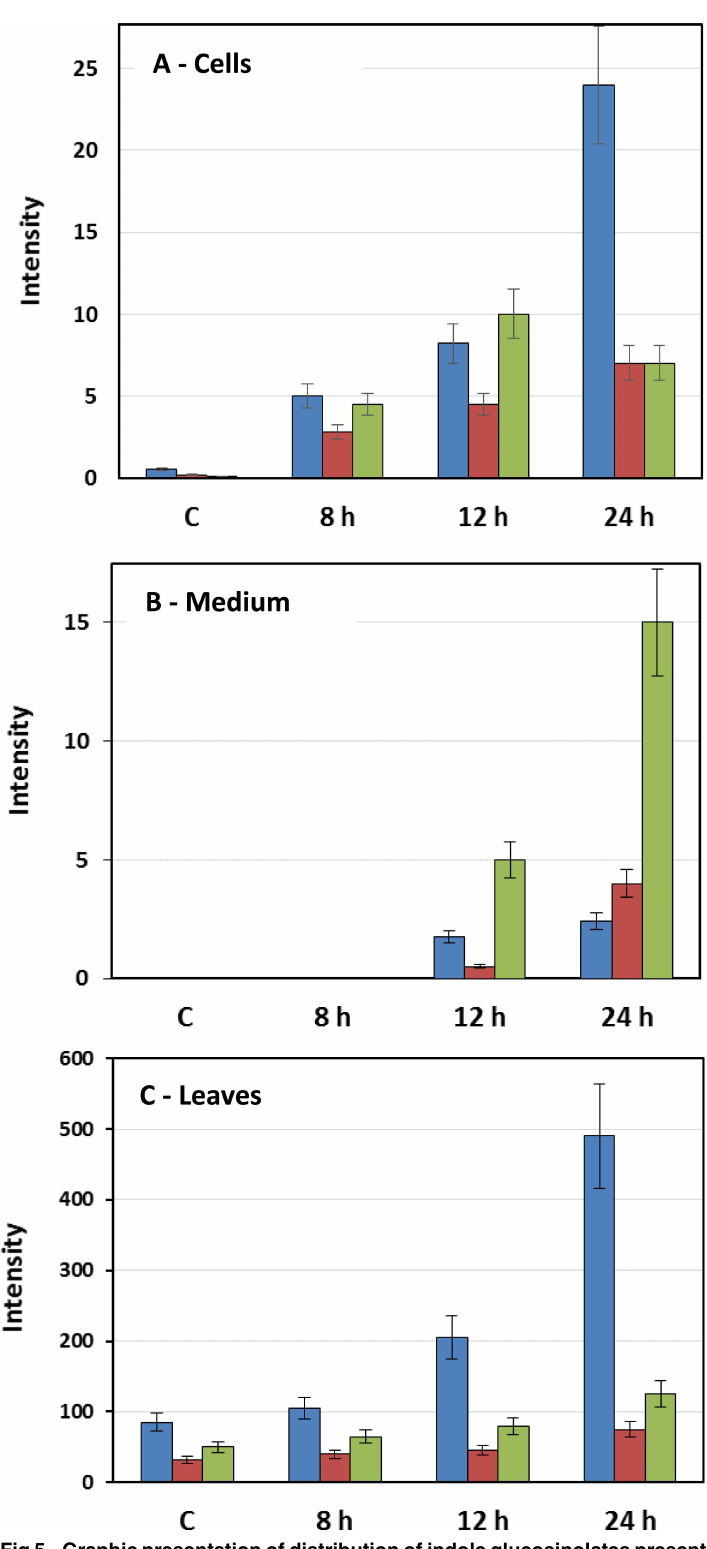
Fig 5. Graphic presentation of distribution of indole glucosinolates present in (A) cell -, (B) medium —and (C) leaf extracts from Arabidopsis elicited with LPS. The graphs show the relative